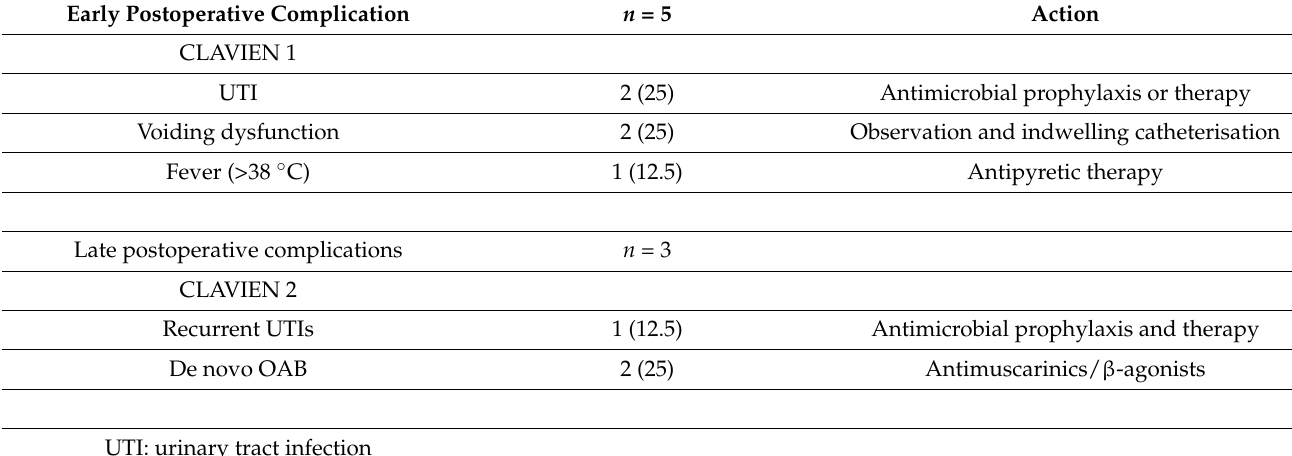
Table 3. Clavien–Dindo classification of early and late postoperative